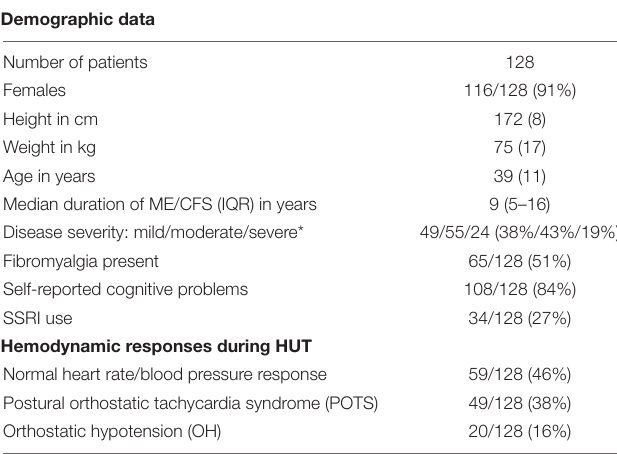
TABLE 1 | Demographic data and hemodynamic HUT results of the study